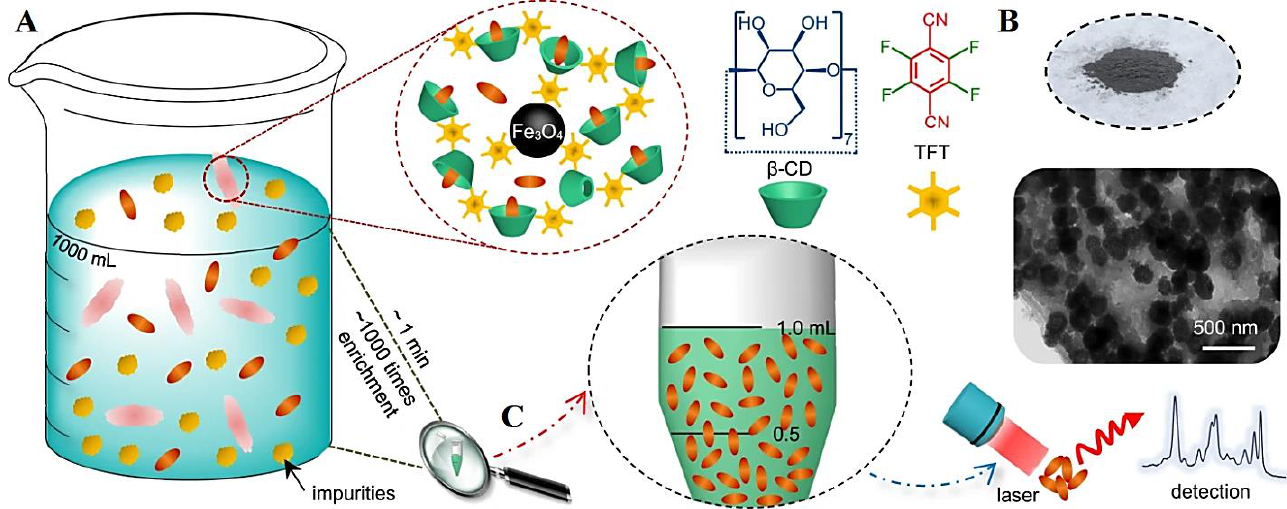
Figure 1. ( A – C ) The processes of adsorption/desorption by applying magnetic nanoparticle immobi- lized β -cyclodextrin-based nanosponges with highly efficient enrichment potentials. Adapted with permission from Ref. [44]. Copyright 2021, Springer Nature, CC BY 4.0.